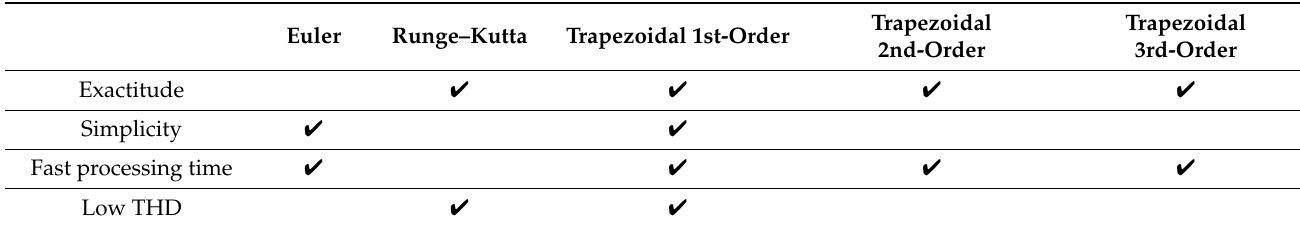
Table 5. Comparison of numerical